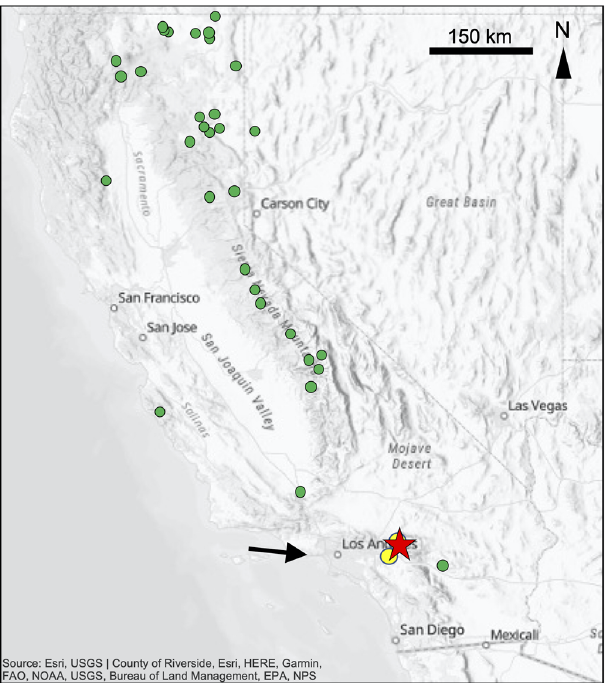
Figure 1. Map showing the location of the Crestline ponderosa pine chronology used in this study (red star). Green circles represent the locations of existing ITRDB ponderosa pine chronologies, available at https://www.ncdc.noaa.gov/data-access/paleoclimatology-data. Black arrow denotes the dominant wind direction over the study site [44,45] and yellow circles locate the sites of NO 2 (southern circle), and ozone (northern circle) air pollution measurements [46].